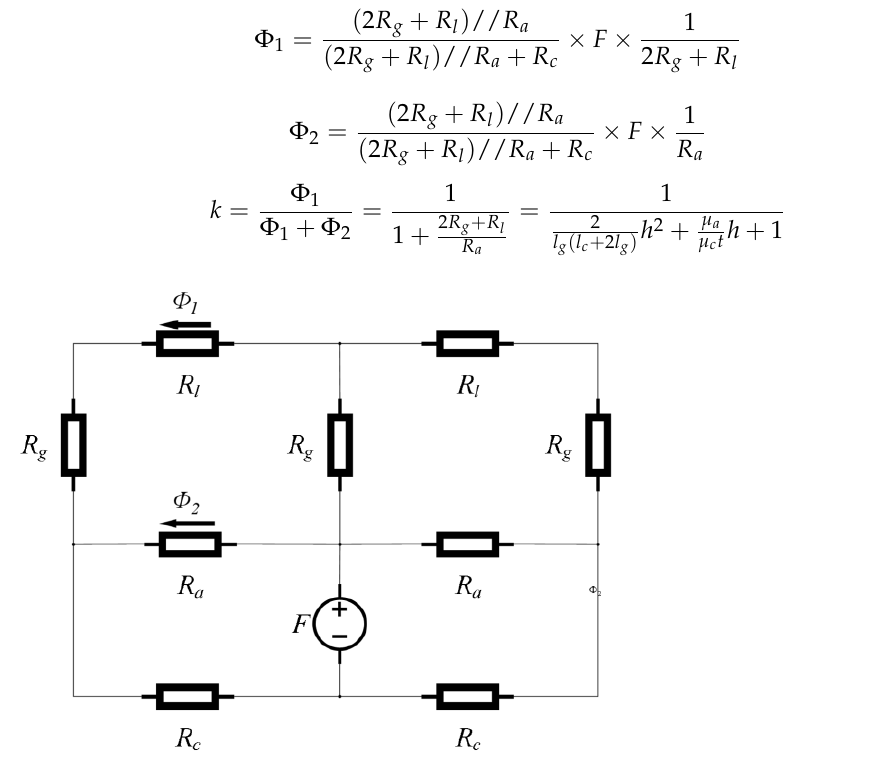
Figure 4. Magnetic model of single coil coupler.